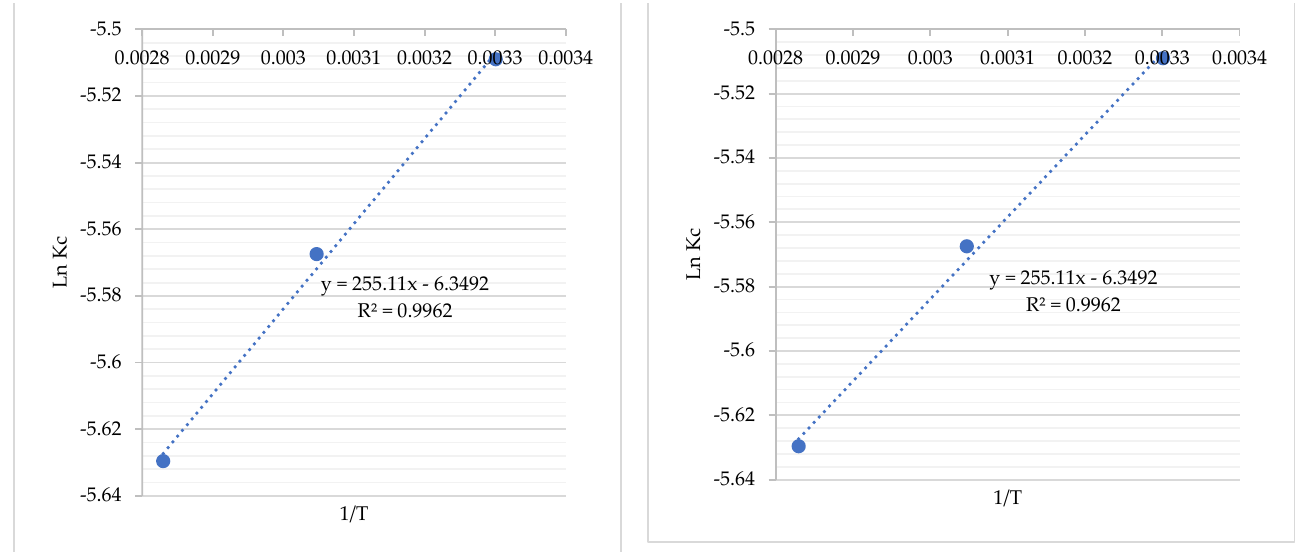
Figure 6. lnKc vs. 1/ T plot for thermodynamic parameters calculation. Figure 6. lnK c vs. 1/ T plot for thermodynamic parameters calculation. Table 9. Thermodynamic parameters for the adsorption of hexavalent chromium at pH 2, 200